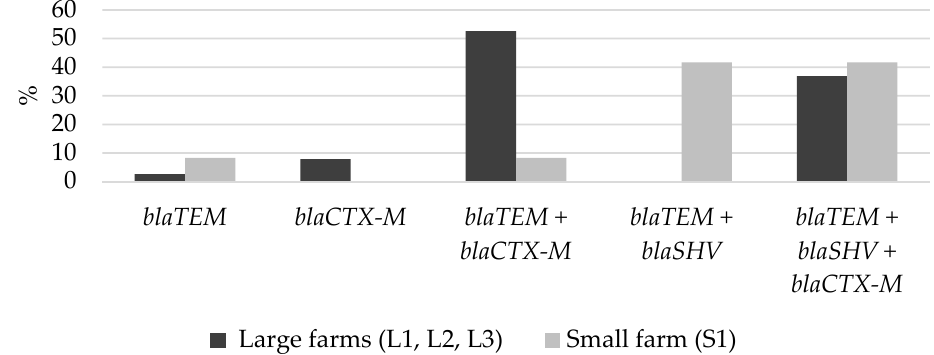
Figure 3. Distribution of beta-lactamase gene(s) on the large and small farms.